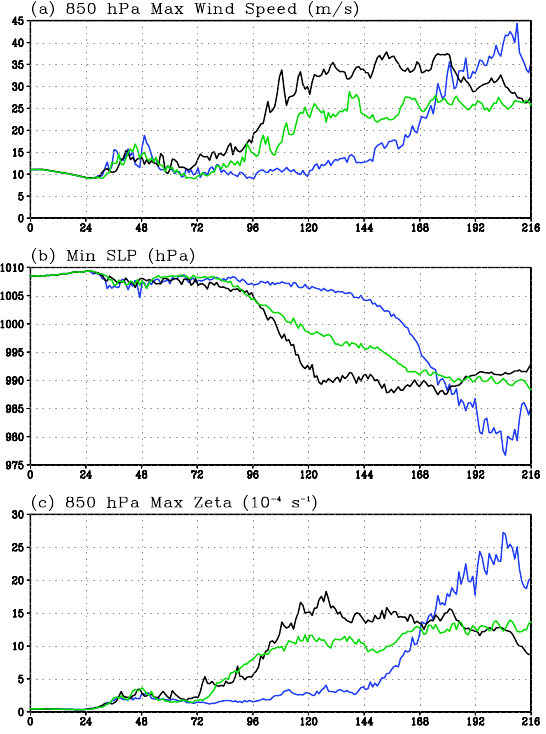
Fig. 7. Time evolution of 850 hPa maximum wind speed (a) , surface pressure (b) , and 850 hPa maximum relative vorticity (units: 10 − 4 s − 1 ) (c) . The black curve is for the single-grid, coarse-resolution simulation, the green curve is the high-resolution, nested simulation with warm rain microphysics, and the blue curve is the high-resolution, nested simulation with ice microphysics. The abscissa is time (h).